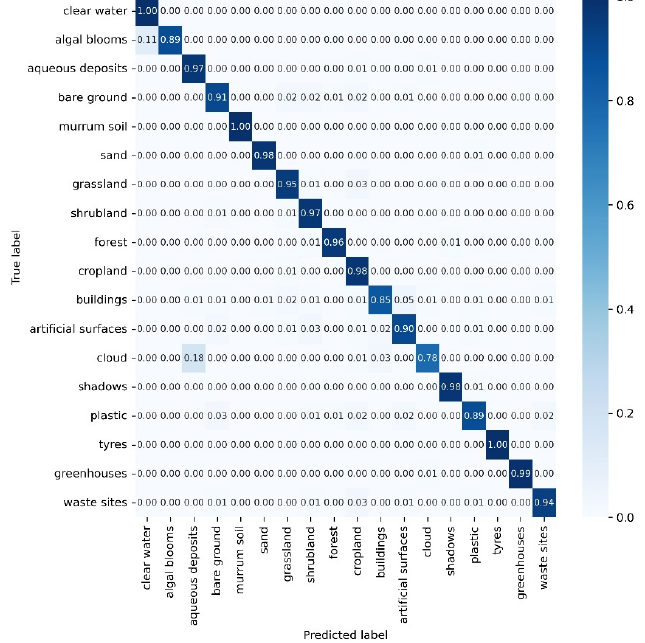
Figure 6. Artificial Neural Network model ( top ) and Random Forest ( bottom ) confusion matrix generated during the training process.